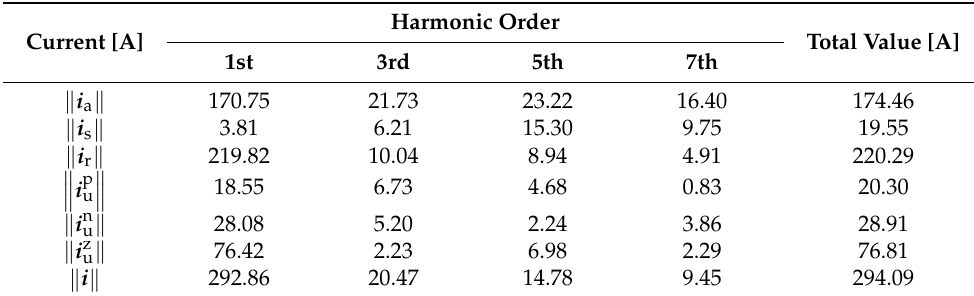
Table 4. List of the values of the currents’